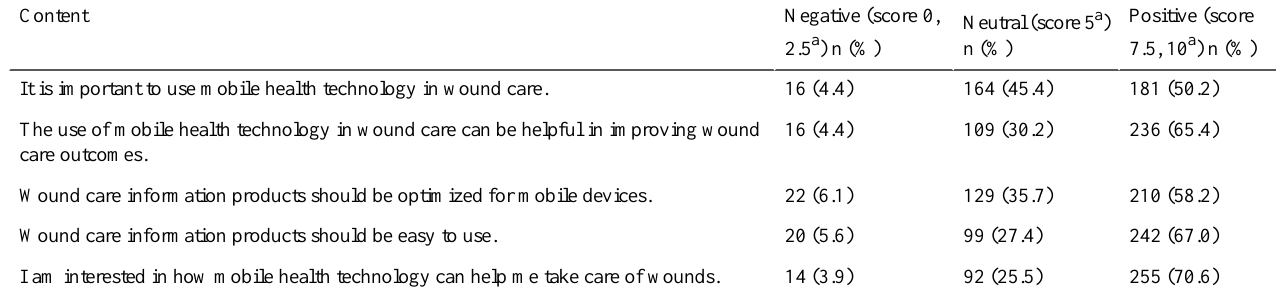
Table 5. Mobile health technology use of participants (n=361).